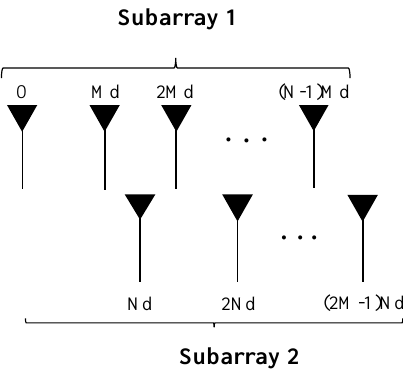
Figure 1. Coprime array